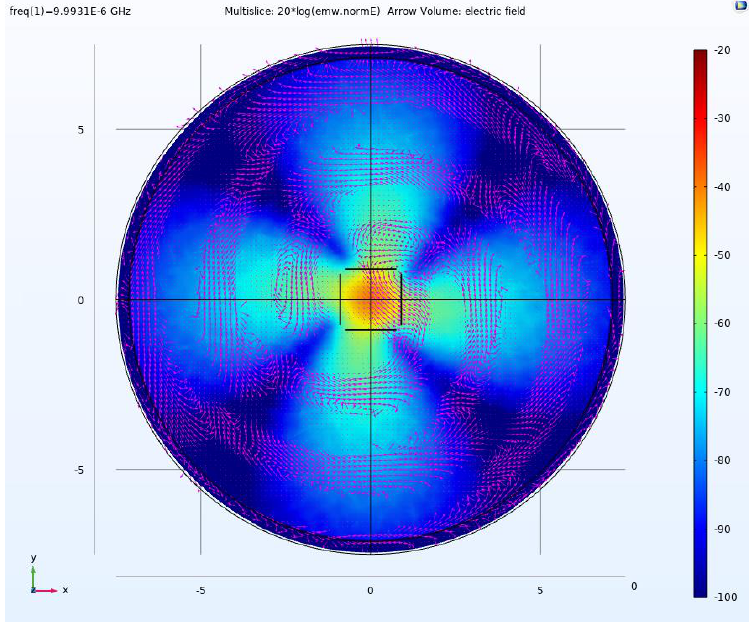
Figure 16. Electric field distribution and direction on the plane 10 km below the MD plane.